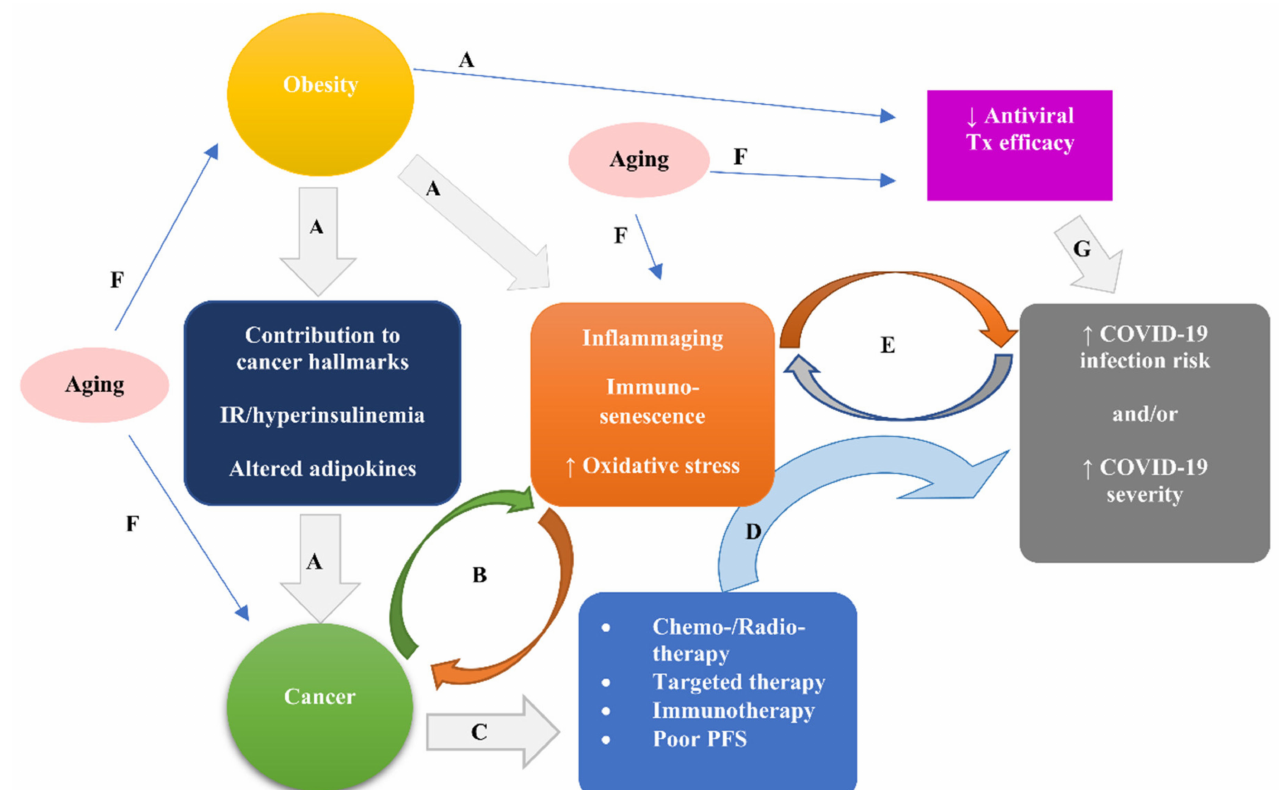
Figure 2. The interplay between obesity, cancer, immunity, and oxidative stress presumed to underlie the pathophysiological landscape of the COVID 19–cancer association. Obesity via contribution to all cancer hallmarks, and stimulation of insulin resistance leading to hyperinsulinemia, and of altered adipokines can promote cancer initiation and progression (A). The obesity-elicited states of inflammaging, immunosenescence, and increased oxidative stress (A) can promote and be promoted by cancer (B). Cancer due to attendant treatments (i.e., chemo-/radio-therapy, targeted therapy, and immunotherapy) and possible poor performance status (C) can increase susceptibility to and severity of COVID-19 (D). COVID-19 risk and/or severity can aggravate and be aggravated by the states of inflammaging, immunosenescence, and increased oxidative stress (E), the latter being elicited by obesity (A) and/or cancer (B). Aging can be a risk factor for obesity, cancer, inflammaging, immunosenescence, and increased oxidative stress (F), leading eventually to increased risk and/or severity of COVID-19 via mechanisms A, B, C, D, and E. Additionally, both aging (F) and obesity (A) may decrease the efficacy of immune-based antiviral treatments, increasing the severity of COVID-19 (G). Abbreviations: COVID-19, coronavirus disease 19; PFS, performance status; Tx,